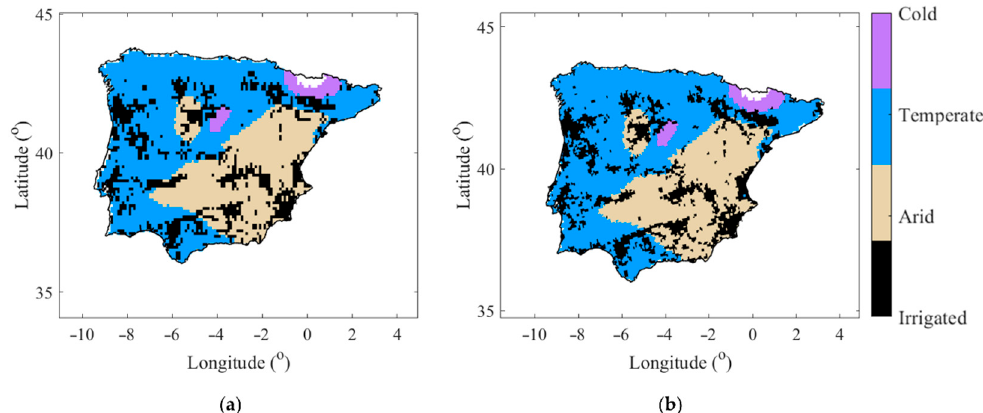
Figure 1. Climate zone (Köppen-Geiger classification) maps obtained at the European Centre for Medium-Range Weather Forecasts (ERA5) ( a ) and Lisflood (LF) ( b ) spatial resolutions. Irrigated areas are marked in black.